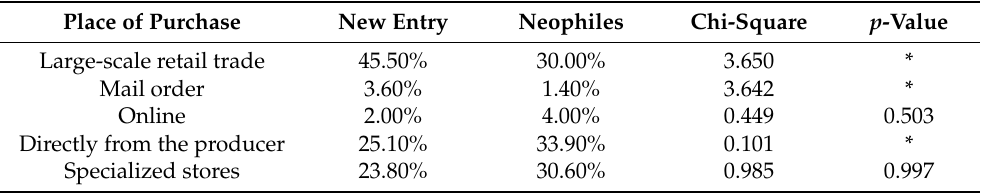
Table 3. Purchase place of alcoholic beverage for new entries ( n = 253) and neophiles ( n = 118). Place of